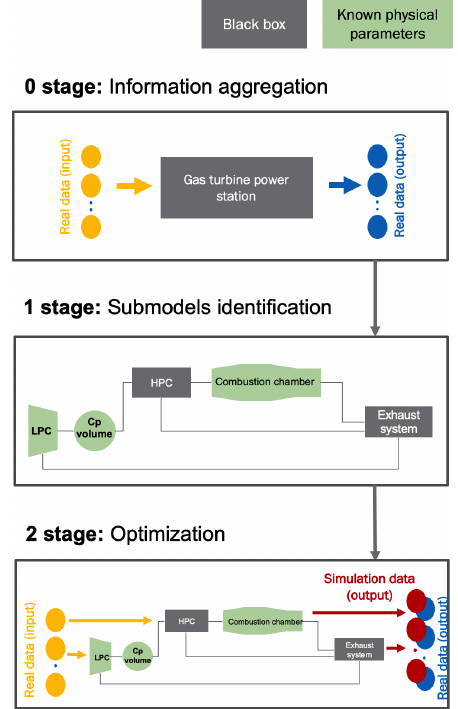
Figure 3. Workflow for physics-based model of a gas turbine power plant